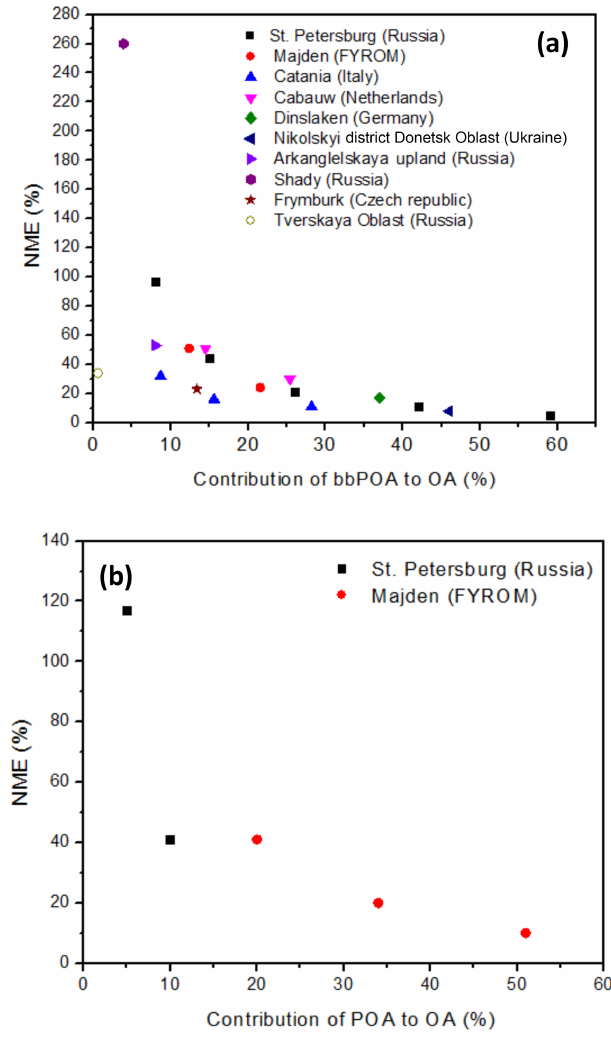
Figure 6. PMF normalized error (%) for ( α ) bbPOA and ( β ) POA for various locations as a function of their contribution to OA.